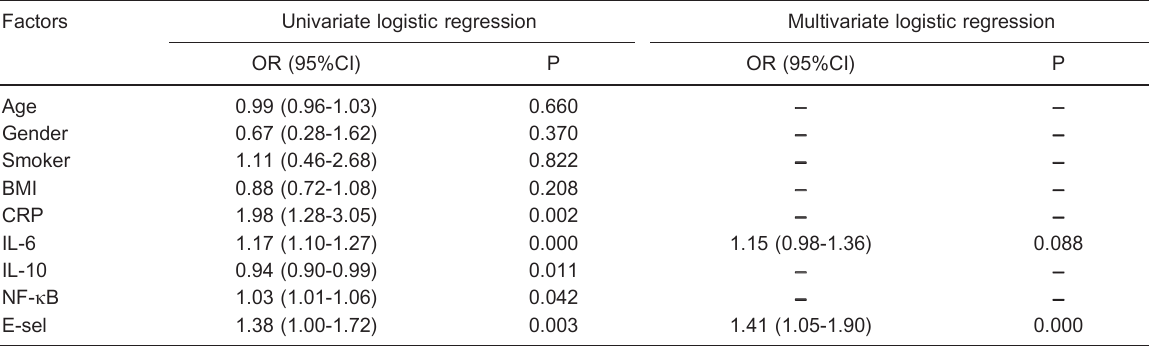
Table 3. Univariate and multivariate logistic regression analyses.